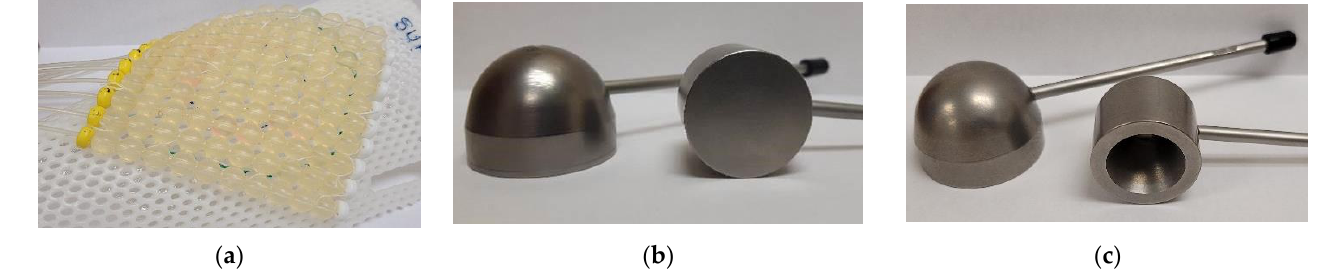
Figure 1. Three common high dose rate (HDR) brachytherapy applicators. ( a ) A 10 catheter Freiburg flap applicator; ( b ) A horizontal 3 cm diameter ( left ) and horizontal 2 cm diameter ( right ) Valencia applicator; ( c ) A horizontal 3 cm diameter ( left ) and horizontal 2 cm diameter ( right ) Leipzig applicator.